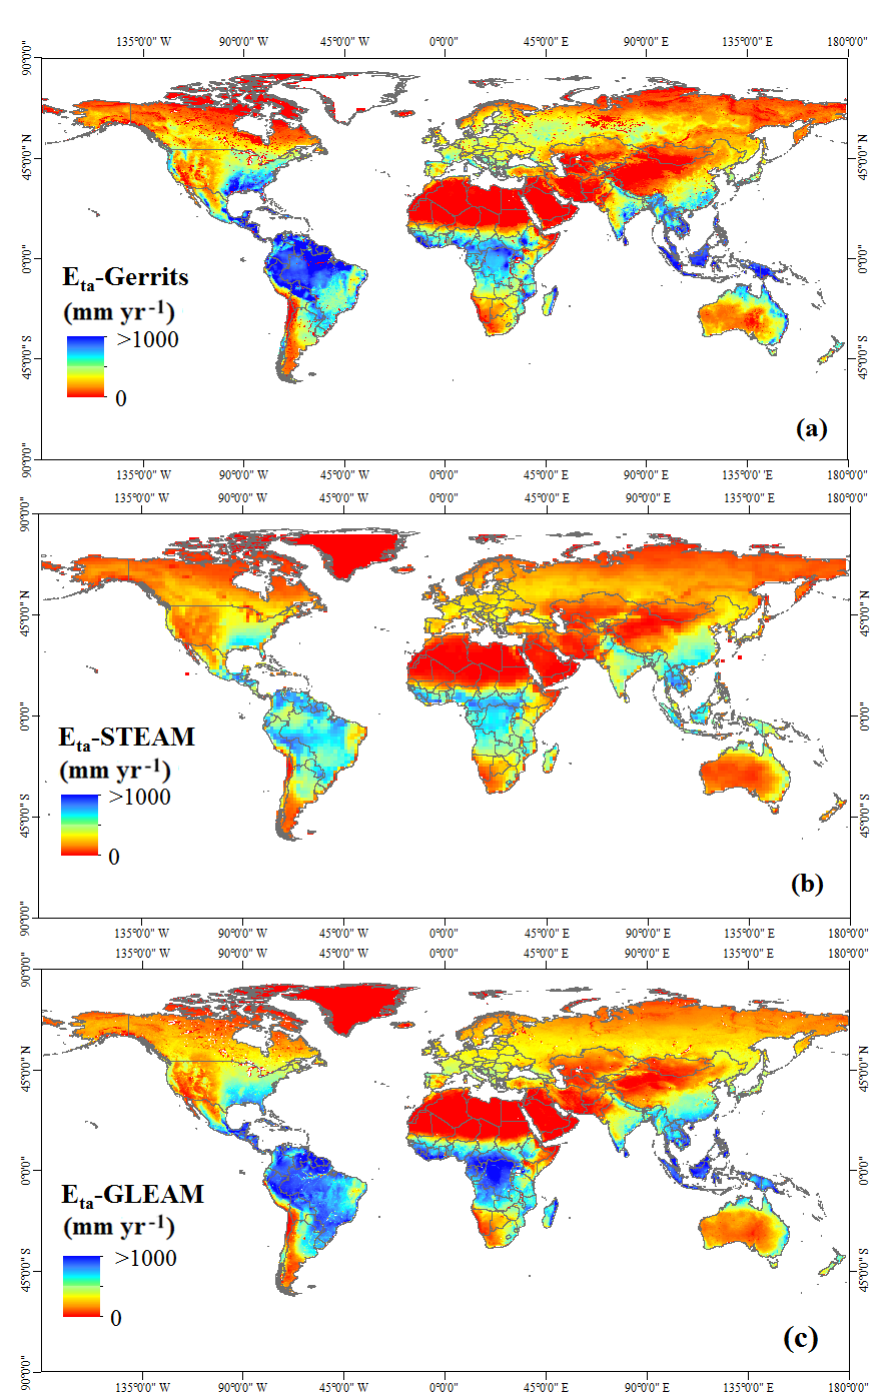
Figure 5. Simulated mean annual transpiration by (a) Gerrits’ model, (b) STEAM, and (c)